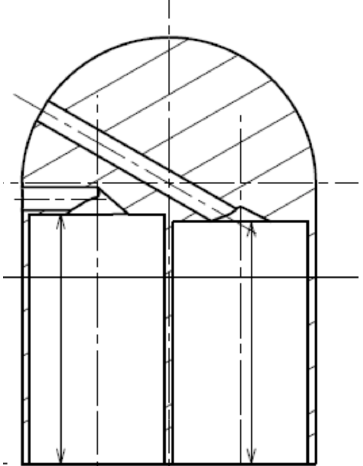
Figure 2. Representation of the spherical FRAPP with aligned taps.